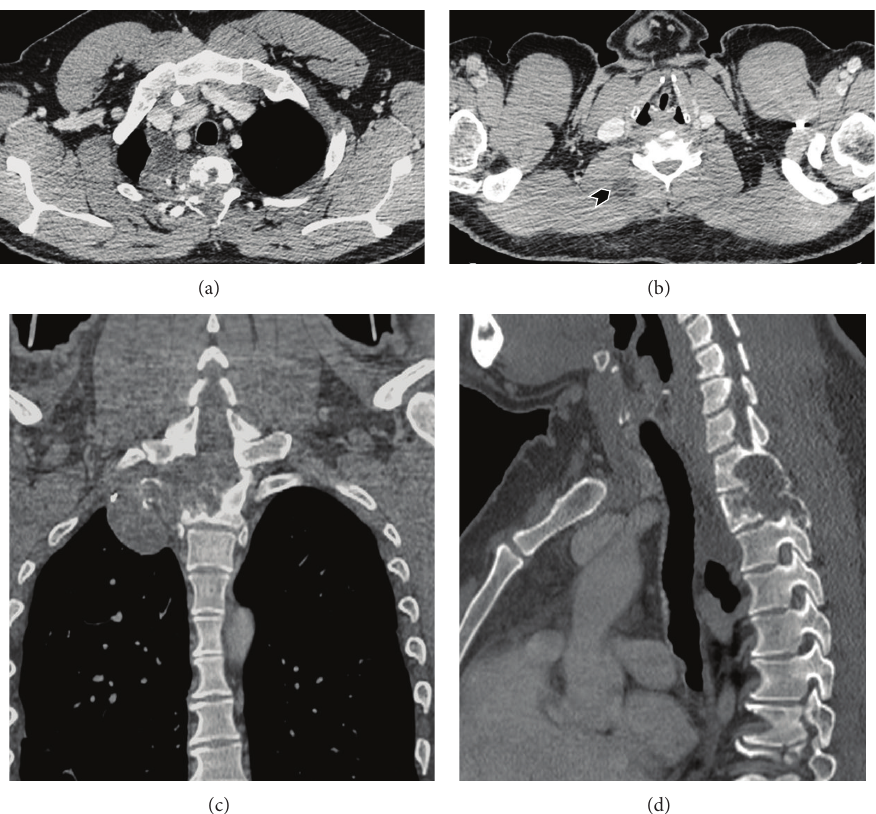
Figure 1: CT exam after intravenous contrast injection: axial (a) and (b), coronal (c), and sagittal (d) planes demonstrate cystic tissue localized in the chest and in the paravertebral muscles on the right (arrow head) and bone erosion of second rib and D1 and D2